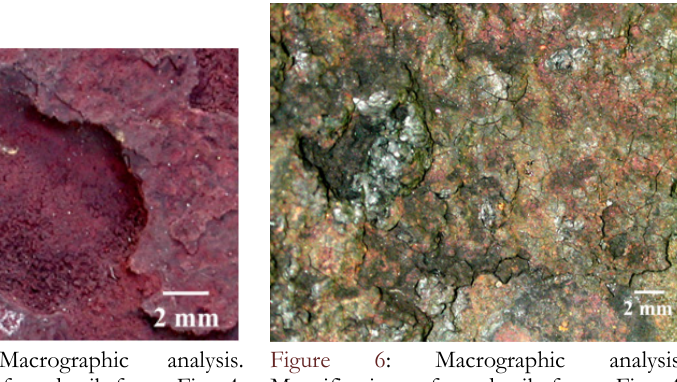
Figure 4: Macrographic analysis. View of the internal surface of a pipe take from a pre-heating fornace.